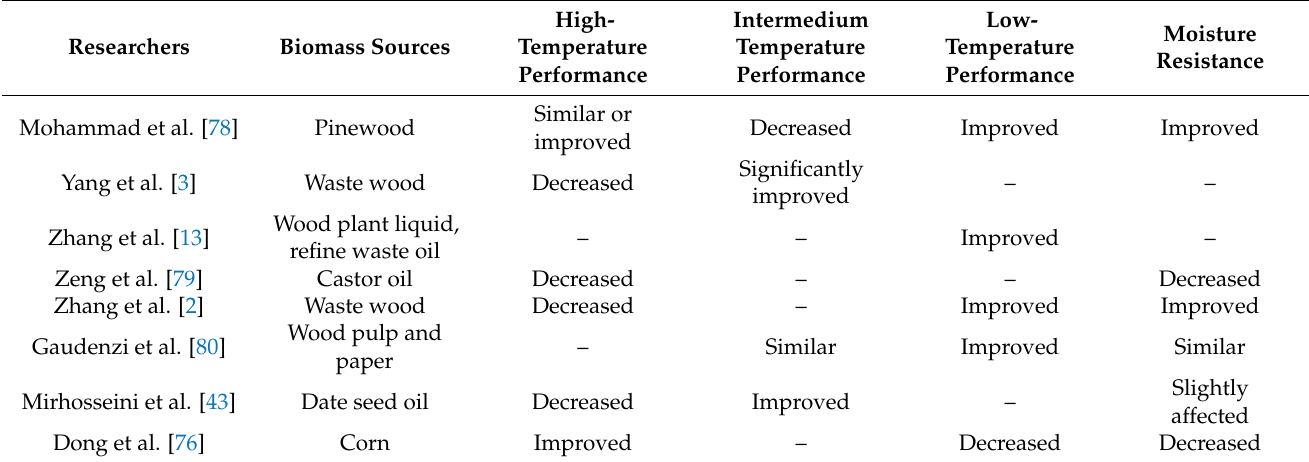
Table 10. The influences of bio-oils on the performance of asphalt